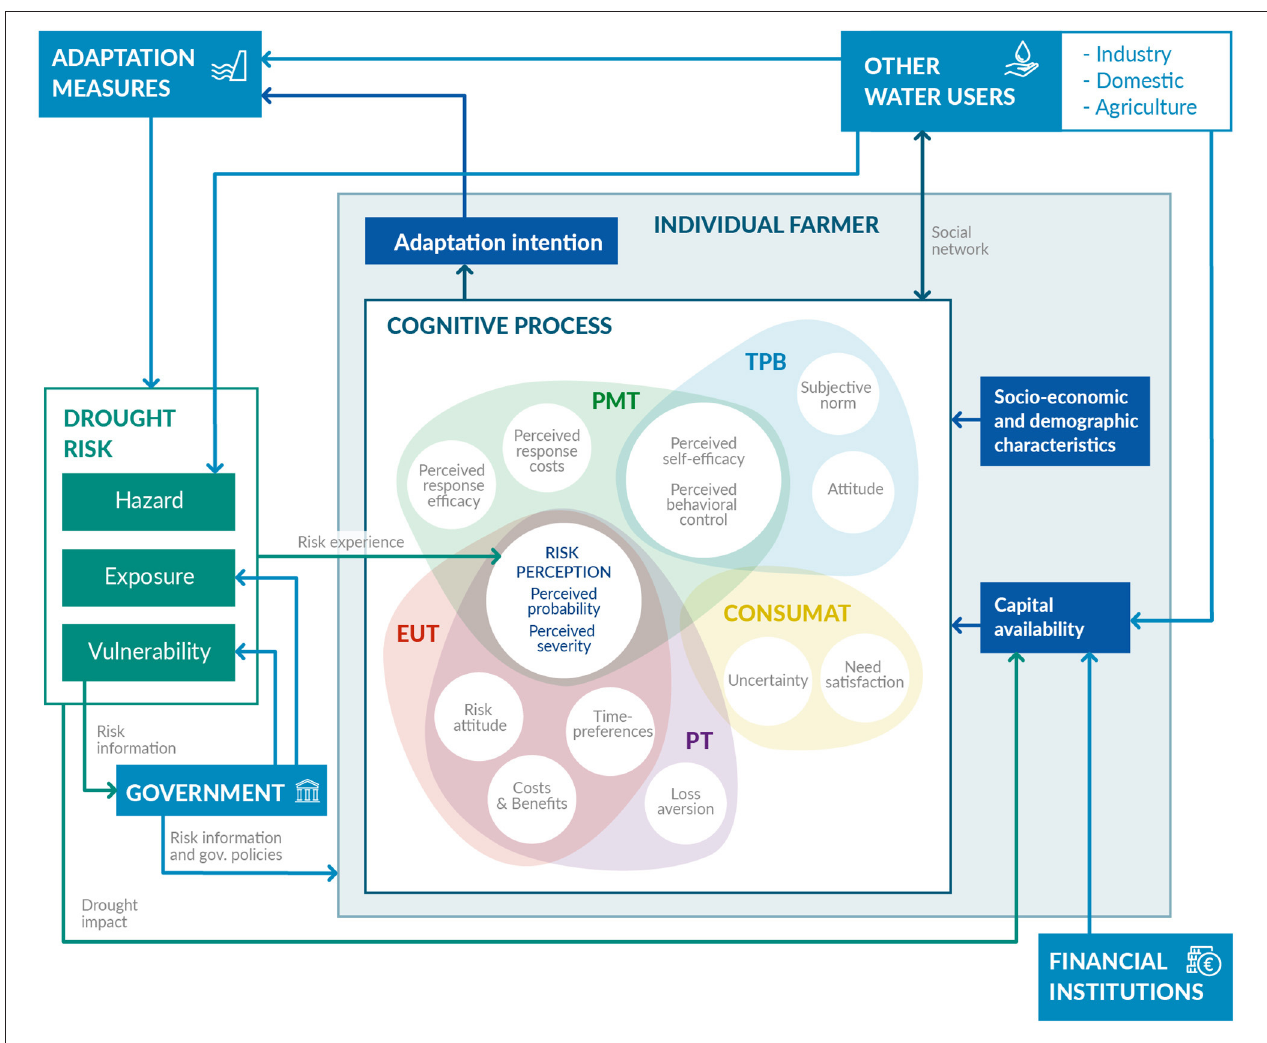
FIGURE 1 | Conceptual framework agricultural drought risk